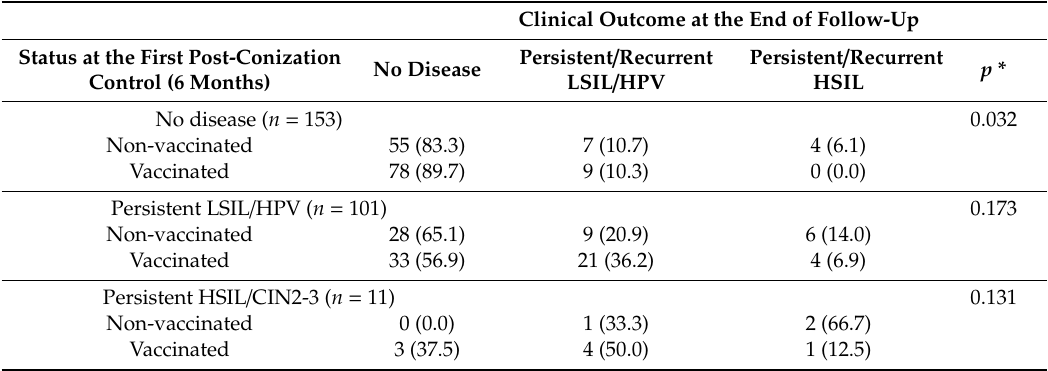
Table 4. Persistent / recurrent disease at the end of follow-up in vaccinated and non-vaccinated women related to the first post-conization control status. Values are absolute numbers and